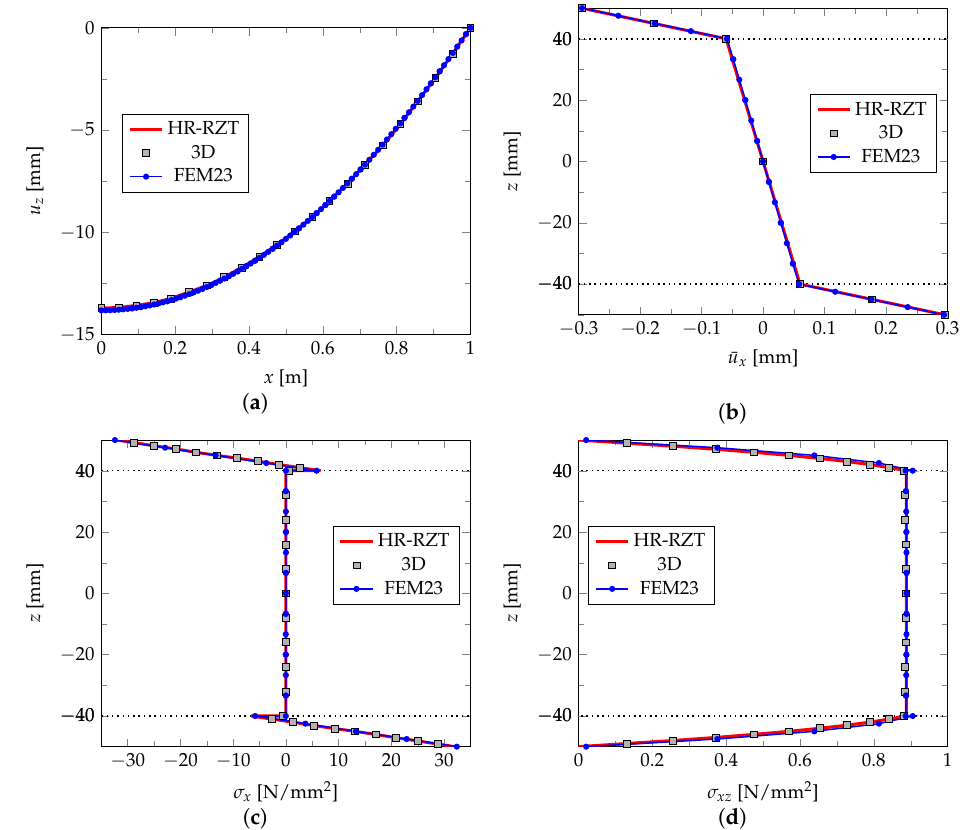
Figure 8. Example 2. Results for plate L1: deflection ¯ u z ( x ,0,0 ) ( a ), displacement ¯ u x ( 3/7 l ,0, z ) ( b ), normal stress σ x ( 3/7 l ,0, z ) ( c ), shear stress σ xz ( 3/7 l ,0, z ) ( d ).